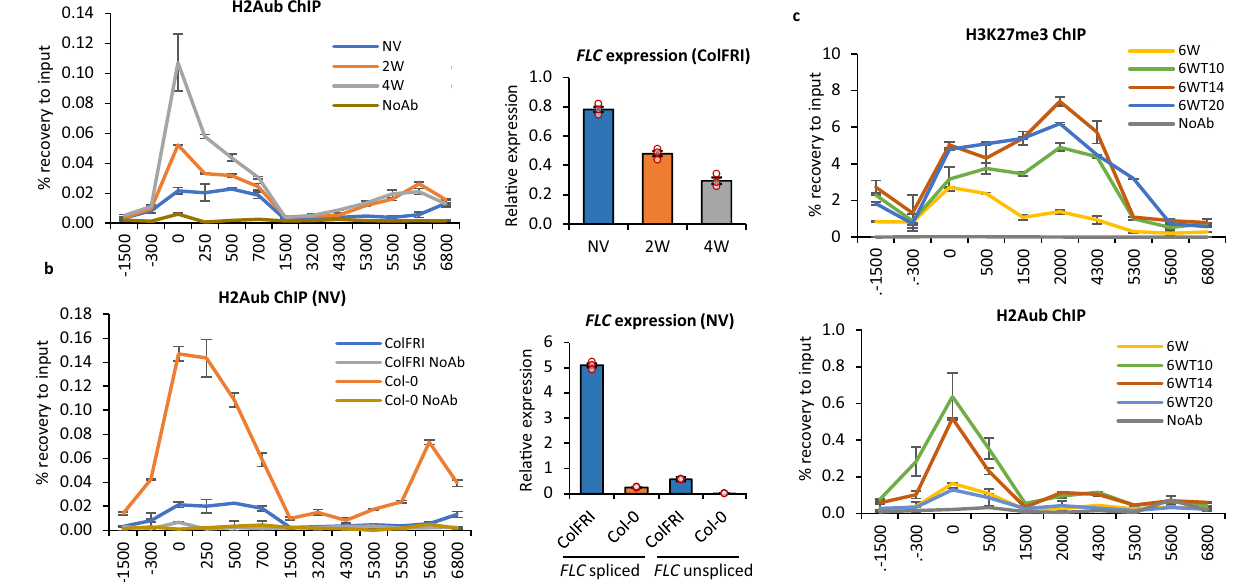
Fig. 5 | H2Aub dynamics at FLC . a H2Aub ChIP showing increased enrichment of H2Aub at the 5 ′ end of FLC in ColFRI during vernalization correlating with decreasing transcription. The graph on the right shows unspliced FLC expression duringavernalizationtimecoursemeasuredbyqRT-PCR.Valuescorrespondtothe mean relative expression to UBC . b H2Aub ChIP enrichment showing antic- orrelation of FLC expression with H2Aub levels . FLC expression in wildtype